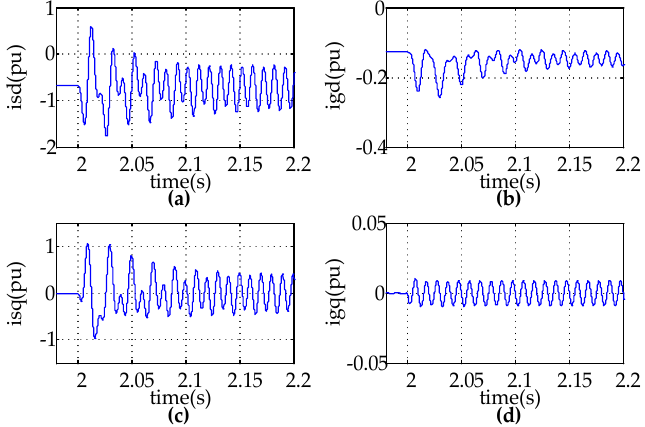
Figure 3. The output current of the DFIG system during grid voltage unbalance: ( a ) Stator active current; ( b ) Grid-side converter active current; ( c ) Stator reactive current; ( d ) Grid-side converter reactive current.